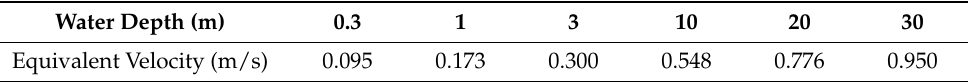
Table 3. Conversion relation of equivalent average velocity at different water depths. Water Depth